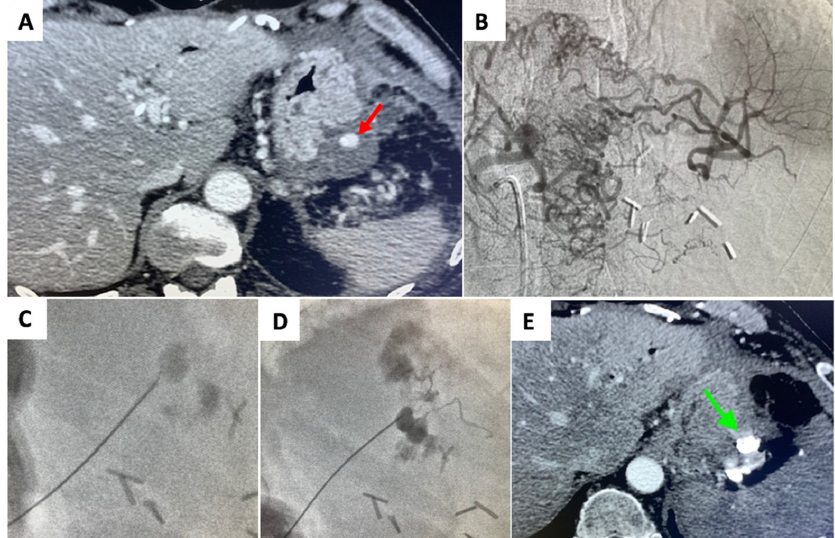
Figure 2. Percutaneous treatment of a left gastric artery PSA ( A ) Contrast enhanced CT demonstrated the PSA (arrow). ( B ) Selective angiography of celiac trunk demonstrated unfeasibility of an endovas- cular approach due to impossibility to reach the PSA ( C ) Under fluoroscopic guidance, percutaneous puncture of the PSA ( D ) and its embolization with N-butyl cyanoacrylate (NBCA) (Glubran II, GEM Italy) were performed. ( E ) Contrast enhanced CT scan after the procedure, showed the complete occlusion of the PSA